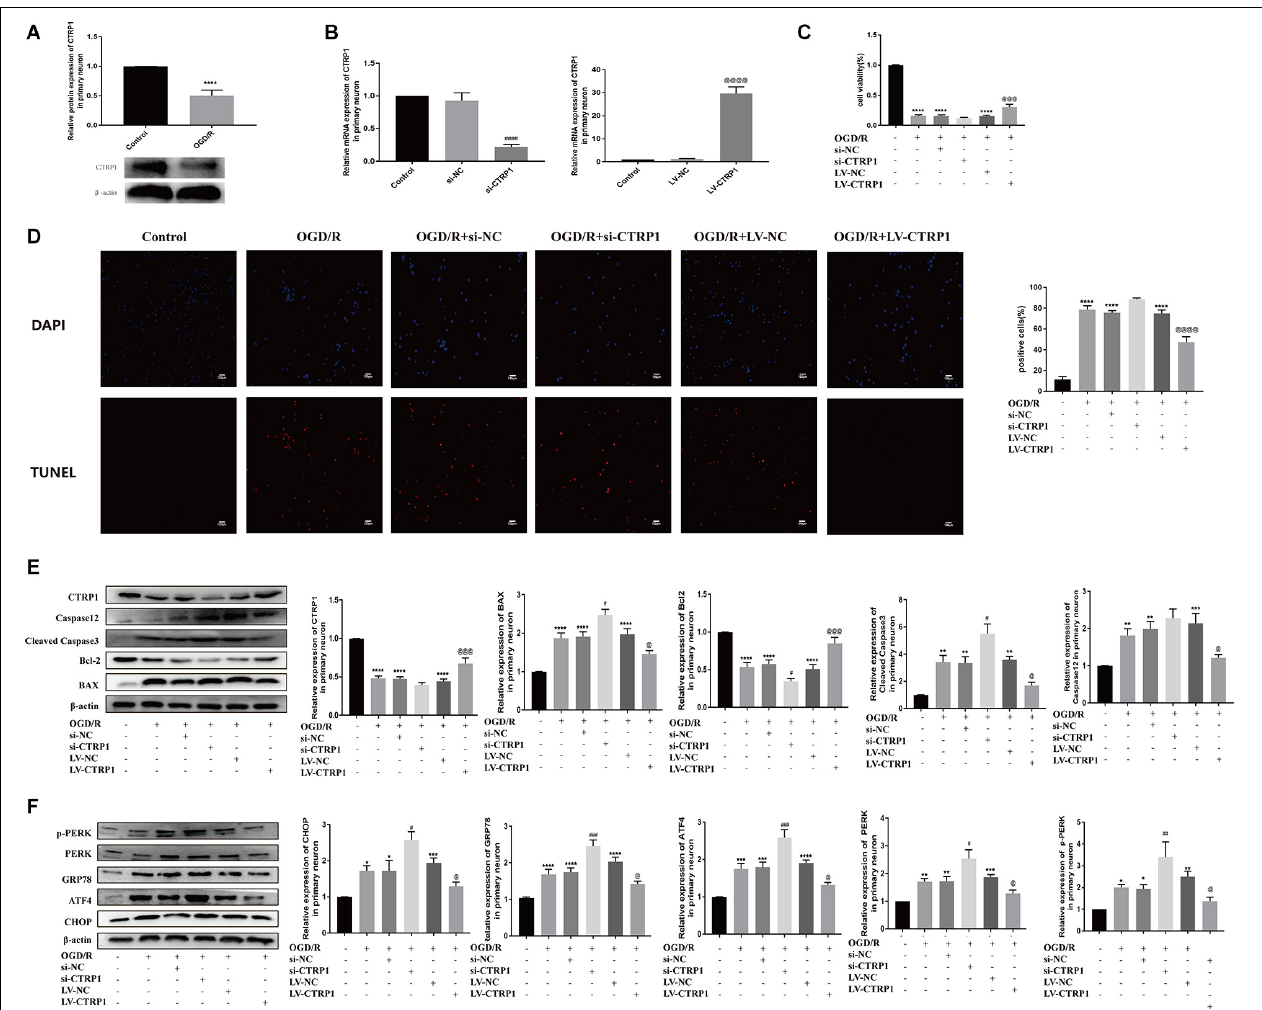
FIGURE 8 | The function of CTRP1 in apoptosis and PERK signal pathway in neurons after OGD/R. (A) The expression of CTRP1 in neurons was analyzed by Western blot. n = 4 per group. (B) qRT-PCR analyzed the mRNA expression of CTRP1 after being transfected with siRNA and overexpression lentivirus, respectively. n = 3 per group. (C) Cell viability of neurons analyzed by MTT, n = 4 per group. (D) Apoptosis was analyzed by TUNEL, n = 3 per group. The representative images were acquired under × 200 magnification, scale bars = 100 µ m. (E) The expression of CTRP1, BAX, Bcl-2, Cleaved caspase3, and Caspase 12 was analyzed by Western blot. n = 4 per group. (F) The protein expression of CHOP, GRP78, ATF4, PERK, and p-PERK in neurons. n = 4 per group. **** p < 0.0001, *** p < 0.001, ** p < 0.01, * p < 0.05 vs. control group, #### p < 0.0001, ### p < 0.001, ## p < 0.01, # p < 0.05 vs. OGD/R + si-NC group, @@@@ p < 0.0001, @@@ p < 0.001, @ p < 0.05 vs. OGD/R + LV-NC